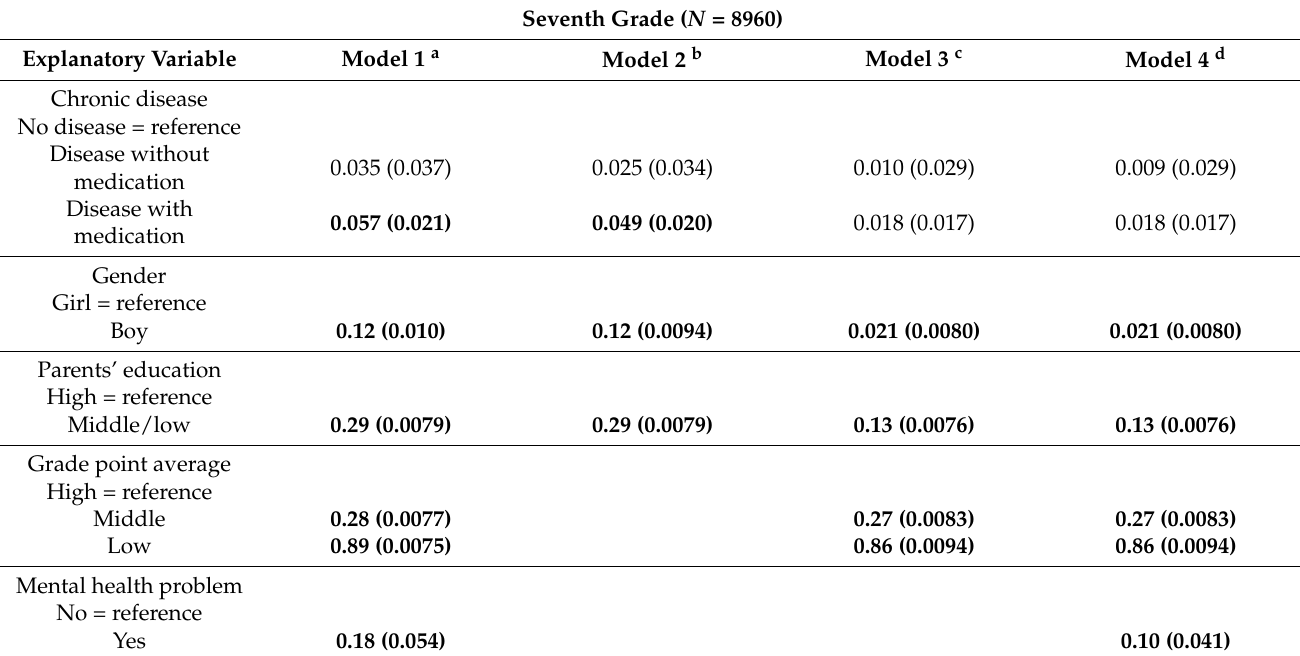
Table A4. Ending up at a non-academic upper-secondary school: the analyses of the logistic models of Table 2 presented as average marginal effects. Standard deviations in